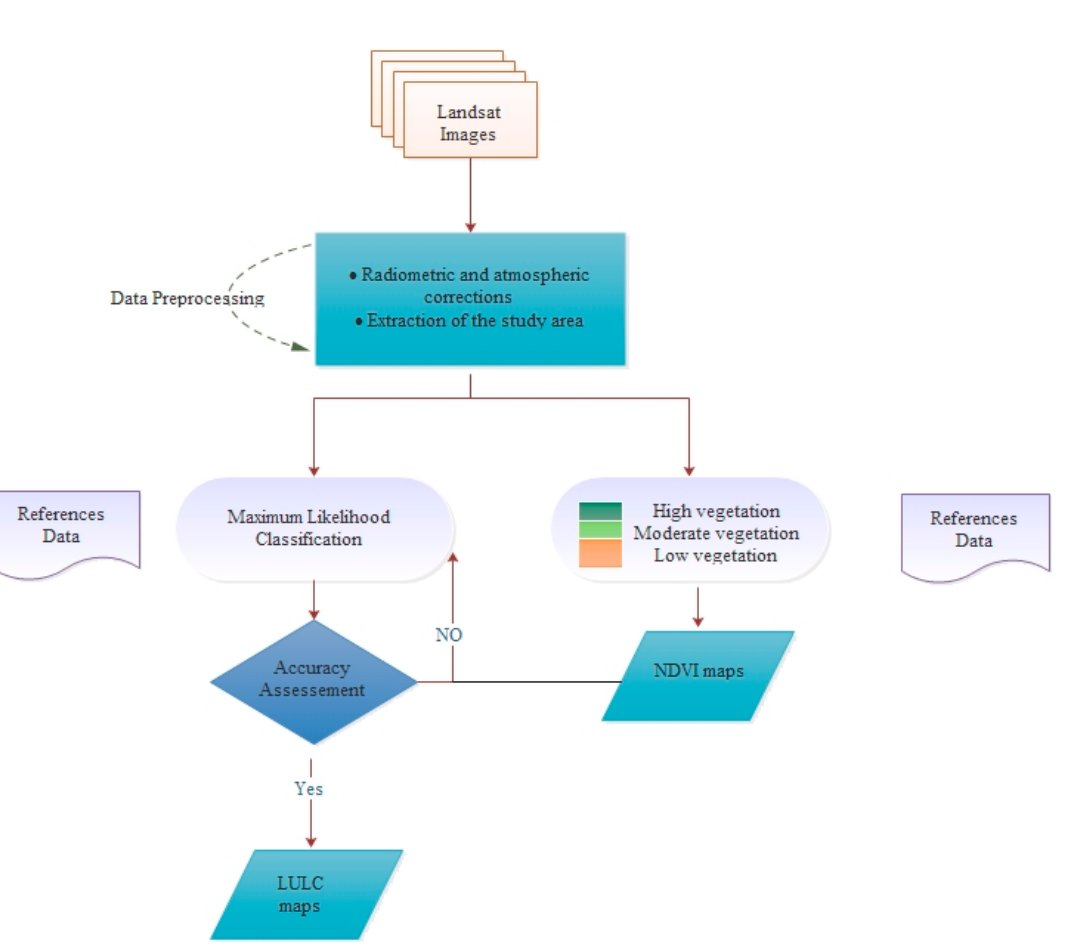
Figure 2. Flowchart of the methodology adopted.